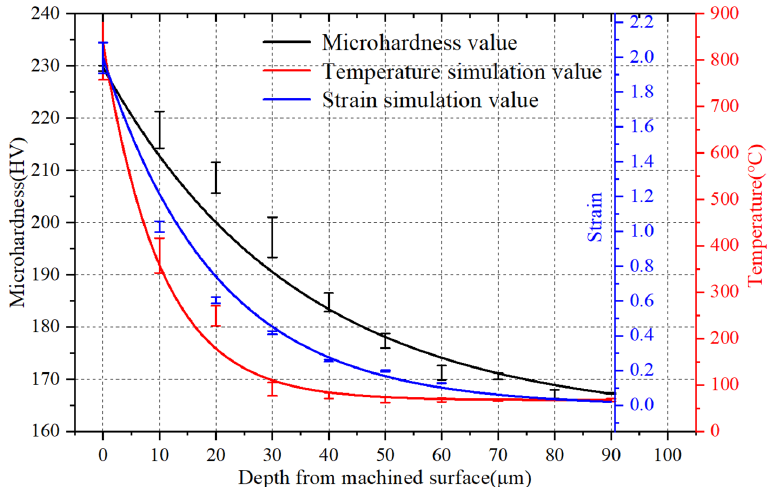
Figure 19. Comparative analysis of simulation and test.